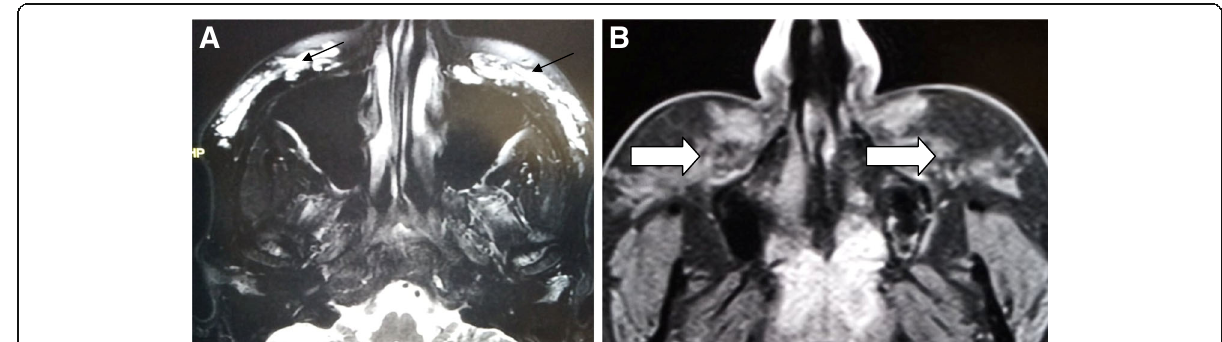
Fig. 1 a T2 Dixon FSE with fat suppression and b post contrast T1 Dixon with fat suppression showing expected distribution and morphology of the facial fillers, in the medial and middle superficial cheek compartment, high signal in T2WI due to high water contents (arrows in a ), no appreciable enhancement following contrast injection (open arrow in b